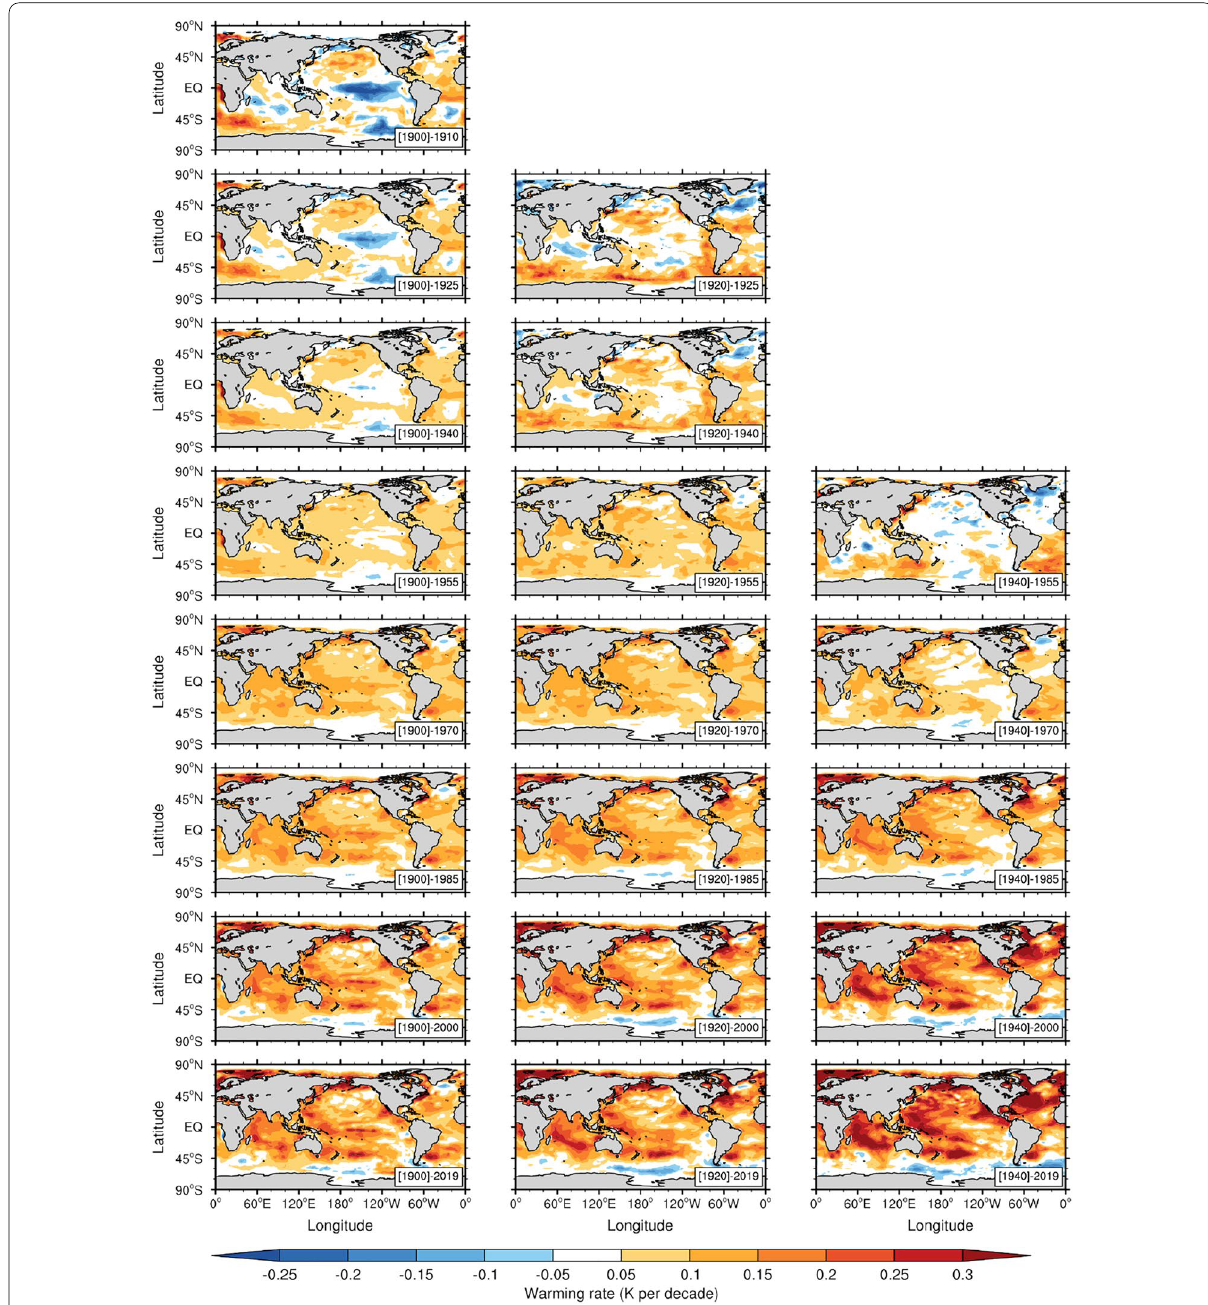
Fig. 3 Warming rate of global sea surface temperature tied to the time interval selection. From top to bottom, the instantaneous warming rate of the secular trend in 1910, 1925, 1940, 1955, 1970, 1985, 2000, and 2019, respectively. From left to right, the instantaneous warming rates are